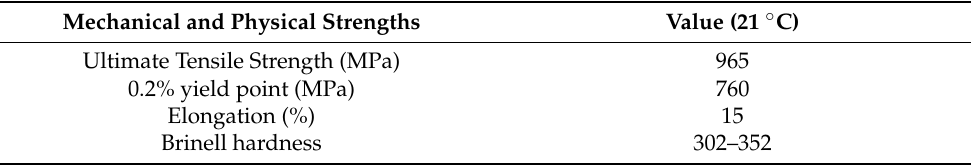
Table 1. Mechanical and physical strengths of 418 alloy. Own study based on [45]. Mechanical and Physical